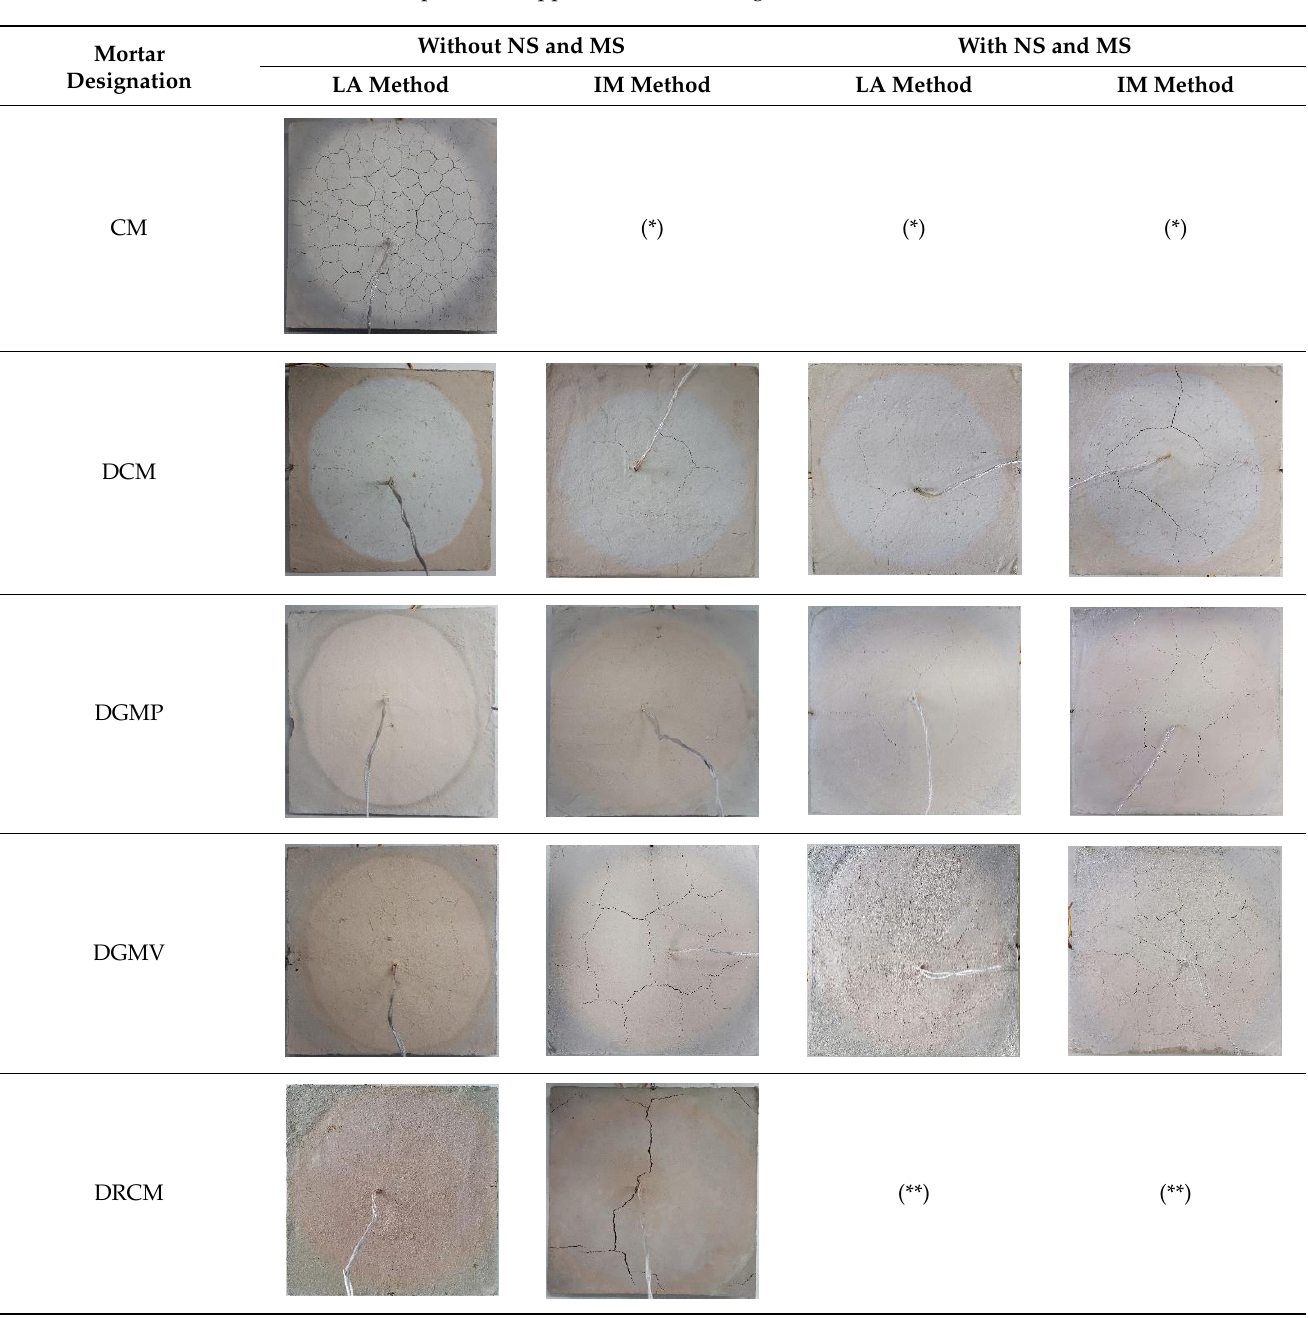
Table 7. Specimens’ appearance after testing. Table 7. Specimens ’ appearance after testing. Table 7. Specimens ’ appearance after testing. Table 7. Specimens ’ appearance after testing. Table 7. Specimens ’ appearance after testing. Table 7. Specimens ’ appearance after testing. Table 7. Specimens ’ appearance after testing. Table 7. Specimens ’ appearance after testing. Table 7. Specimens ’ appearance after testing.